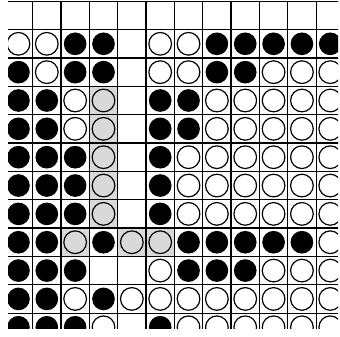
Figure 50. BLACK wins.